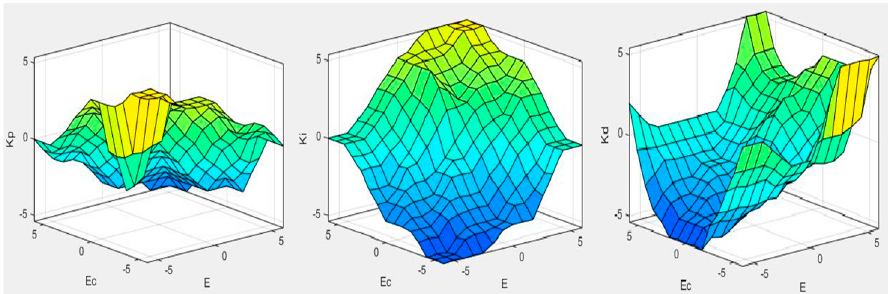
Figure 9. Three-dimensional model diagram of ∆ Kp, ∆ Ki, and ∆ Kd as the output results. Defuzzifying the fuzzy sets of p K Δ , i K Δ , and d K Δ using the weighted average